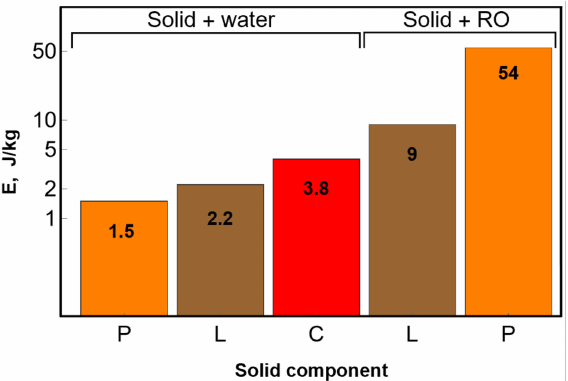
Figure 7. External heating source energy used to convert unit weight of fuel composition. Solid components are peat (P), lignite (L) and bituminous coal processing waste (C). The energy is shown on a log